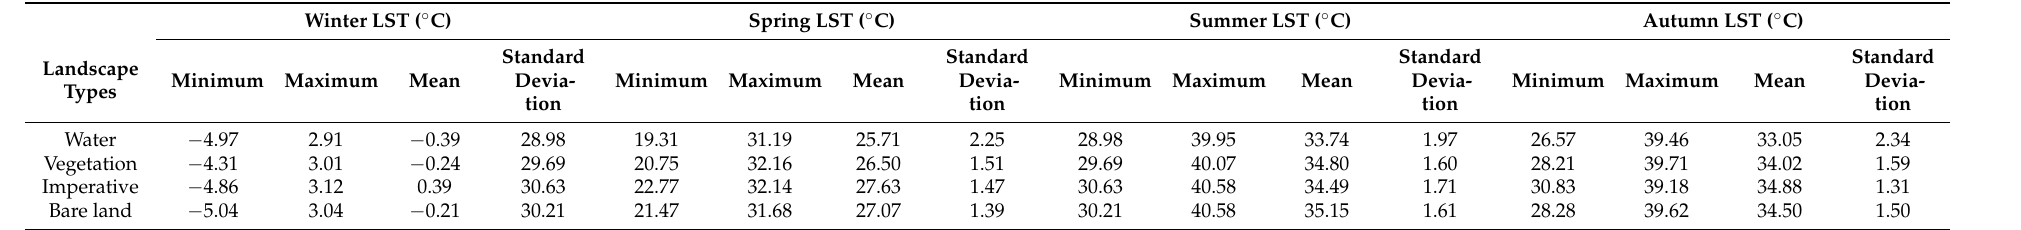
Table 2. LST of each landscape type in